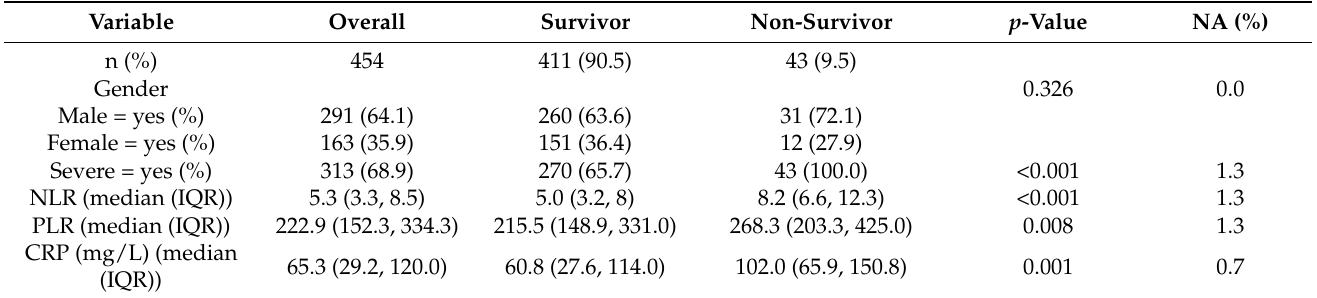
Table 2. Laboratory results of COVID-19 patients among survivors and non-survivors (n = 454).